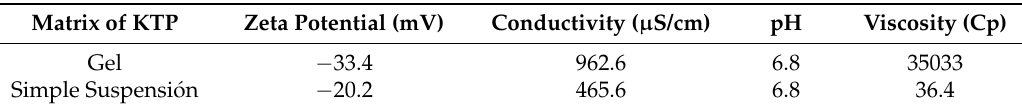
Table 2. Values of Z-potential, conductivity, pH and viscosity obtained for the two KTP formulations at 37 ◦